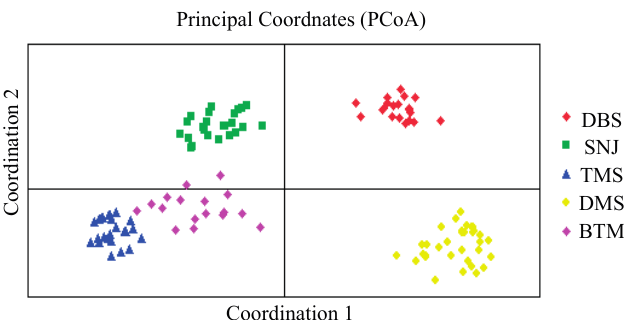
Figure 4. The principal co-ordinate analysis (PCoA) plot of five C. japonicum populations based on the two principal axes.